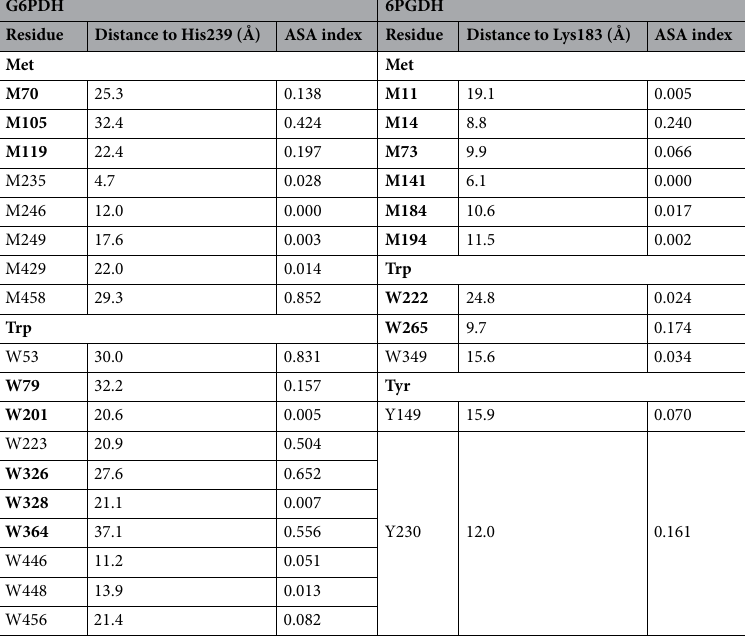
· are indicated in